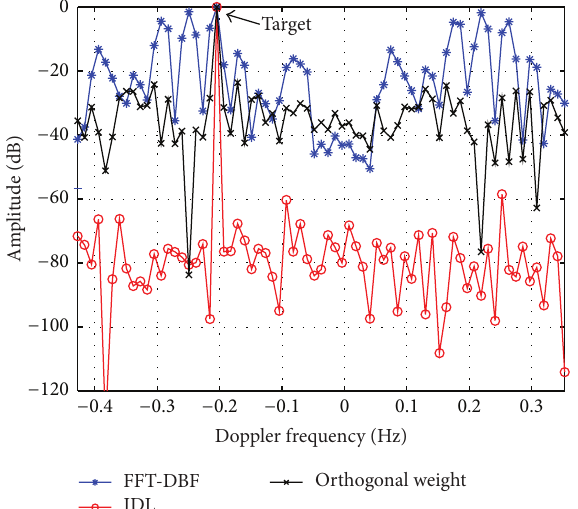
Figure 7: Compared Doppler results (simulated sea clutter, target azimuth 130 ∘ ).